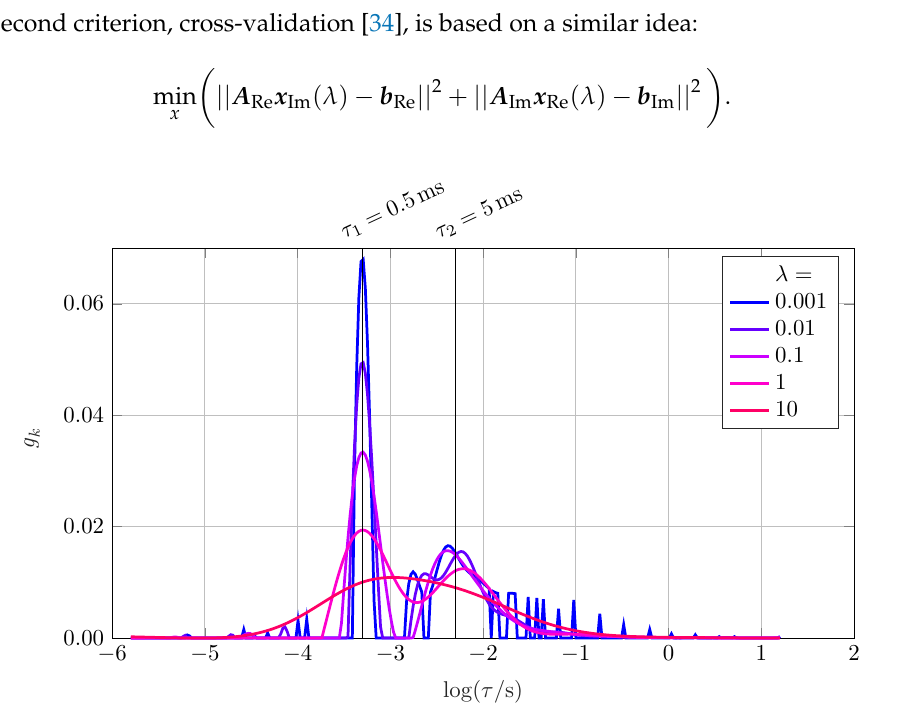
Figure 3. DRT of an RC-element ( R 1 = 5m Ω , C 1 = 0.1F) and a ZARC-element ( R 2 = 7m Ω , C 2 = 0.71F, ϕ = 0.8) in series, calculated at five different λ logarithmically equally-distributed between 0.001 and